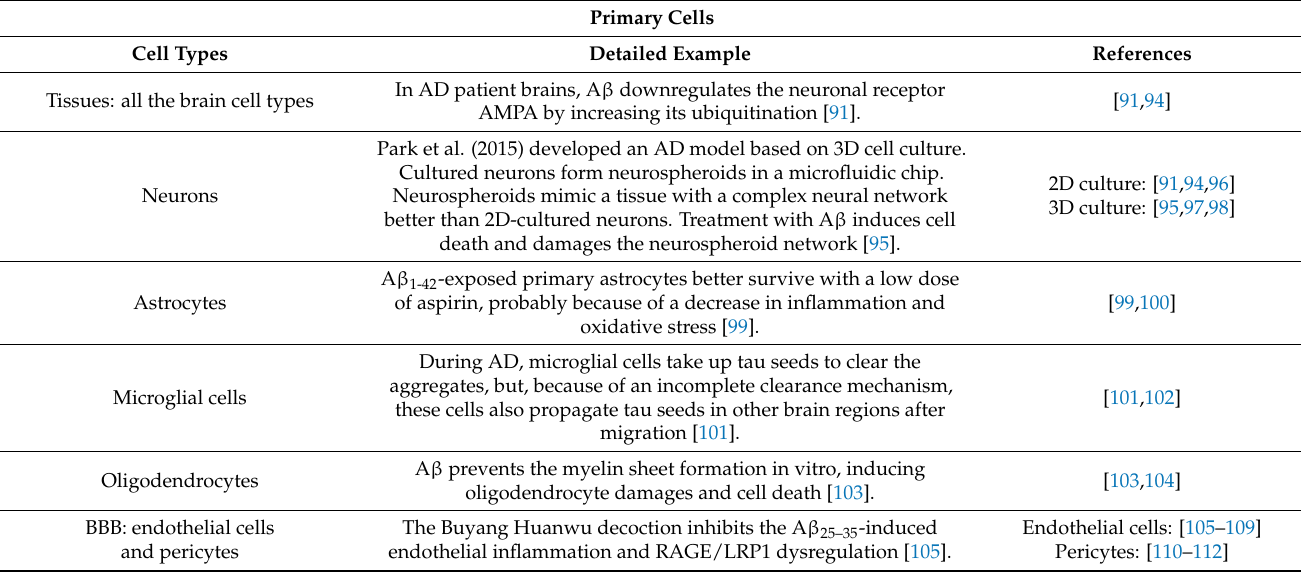
Table 2. Selection of recent key data obtained from AD primary culture